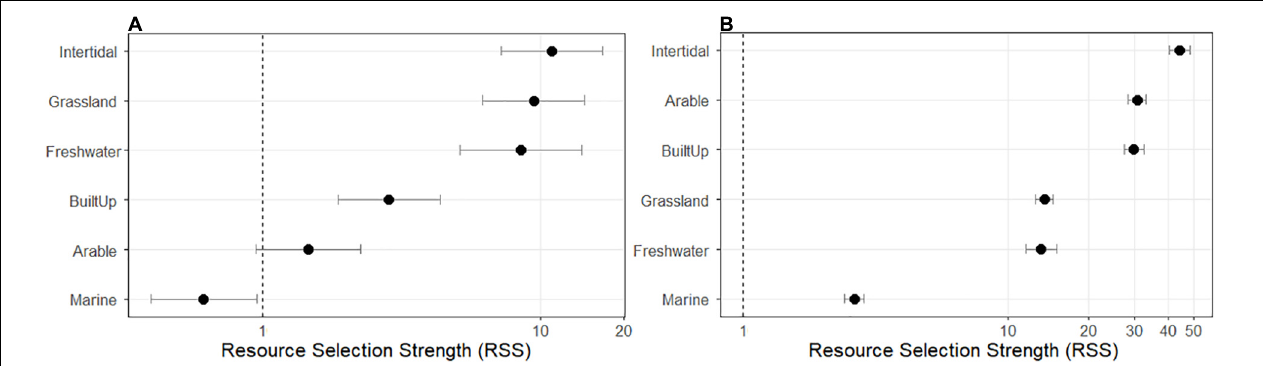
FIGURE 2 | Resource selection strength (RSS) values with lower and upper 95% confidence intervals from the Resource Selection Function model in Supplementary Table 4 for herring gulls in (A) northwest England and (B) southwest Scotland. RSS = 1 (indicated by the dotted vertical line) indicates that use of the habitat is proportional to its availability; an RSS value with 95% confidence intervals not overlapping with the dotted vertical line show habitats that were preferred (RSS > 1) or avoided (RSS < 1) by herring gulls. The reference category was “other” habitat. Note log-scaling of the x